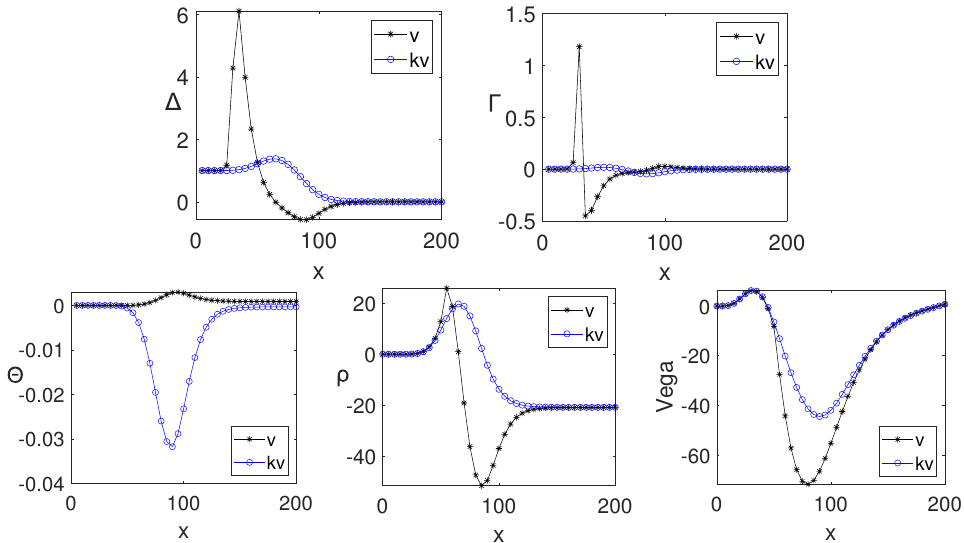
Figure 14. H x = H y = H z = 0.5, figures represent in turn are Delta, Gamma, Theta, Rho and Vega. The blue curve stands for option price with knock-in-barrier while the black curve represents option price without knock-in-barrier. For interpretation of the references to color in the figure, the reader is referred to the web version of the